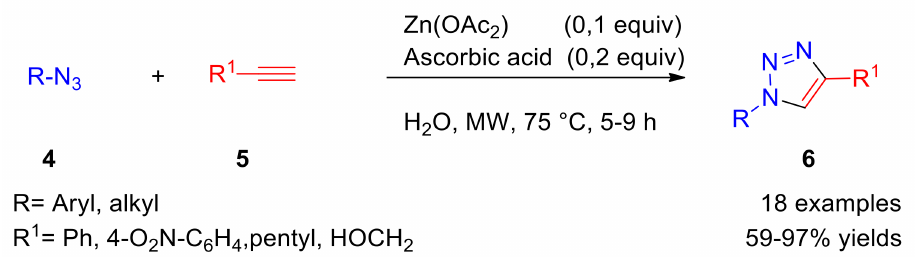
Scheme 3. ZnAAC of organic azides and terminal acetylenes for the synthesis of